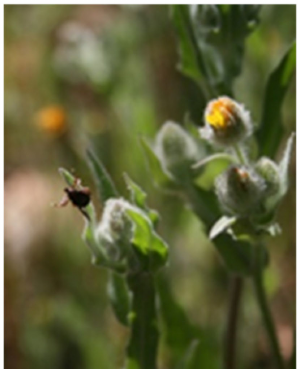
Figure 4. Questing Hyalomma lusitanicum with two front legs extended to expose the Haller organ to detect host